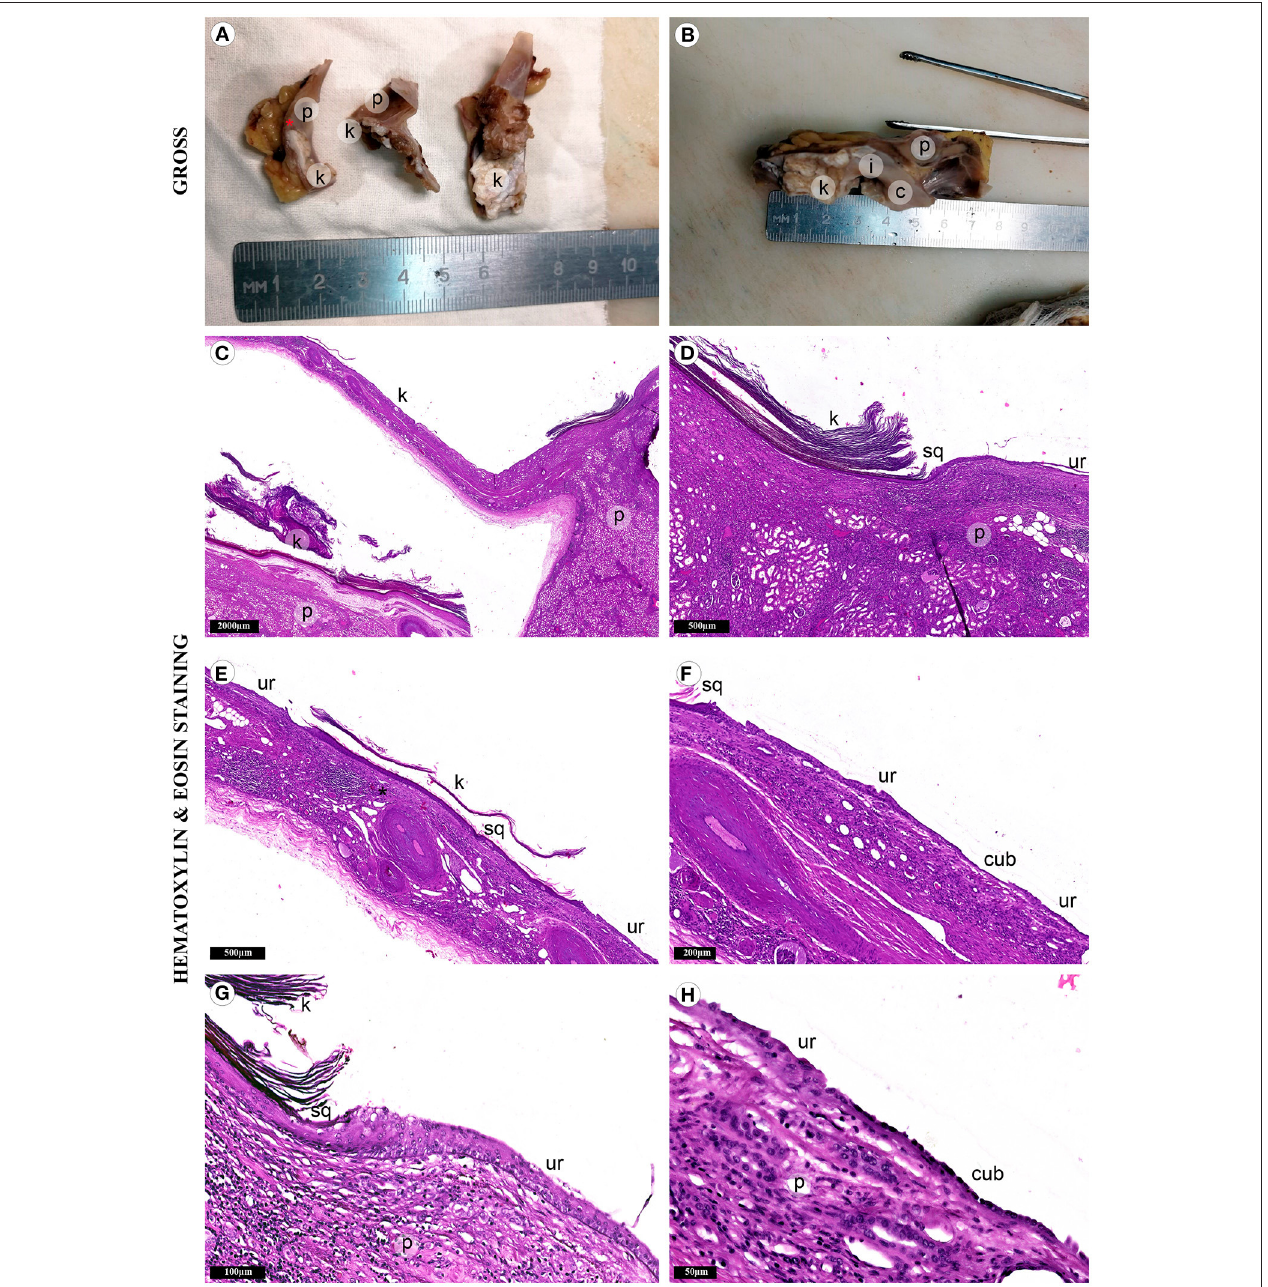
FIGURE 2 | Fragments of the kidney and cystic lesion. Gross evaluation (A,B) demonstrates cystic lesion with adjacent renal parenchyma (p) separated by septa with varying wall thickness. Adhesions tightly connected the lesion with the kidney capsule and adjacent adipose tissue. The lumen was filled with gray-brown cheesy keratinized masses (k). It was connected to the small renal calyx (c) with the isthmus (i). Mucosa of the calyx was gray, smooth, with single overlays of horny masses. (C) The histological study revealed keratinized mass in the lumen of the lesion. (D) The renal parenchyma was separated from the cyst wall with adipose tissue of the renal sinus. (E,F) Three types of epithelium lined the cyst wall: stratified squamous epithelium (sq) with a developed granular layer and hyperkeratosis, urothelium (ur) and simple cuboidal epithelium (cub). (G) We also detected the focuses of chronic inflammatory infiltration. (H) Atrophic renal parenchyma was adjacent to the epithelial lining in some